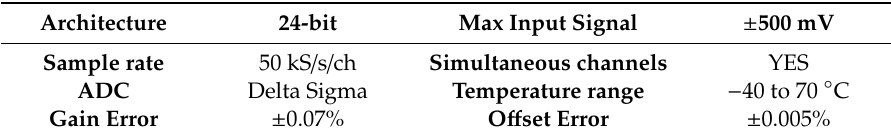
Table 1. Main features of the data acquisition board (DAQ) NI 9238.